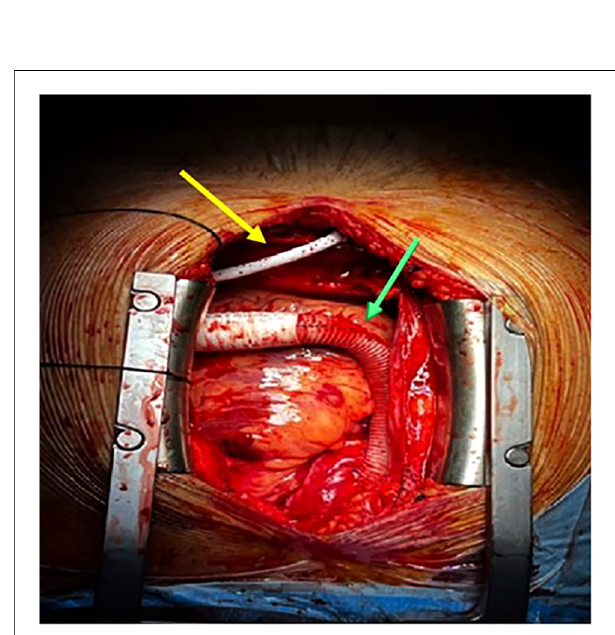
FIGURE 4 Implantation of HeartMate 3 TM LVAD, LVAD HM3 out fl ow graft (green arrow), and LVAD HM3 driveline cable (yellow arrow). LVAD, left ventricular assist